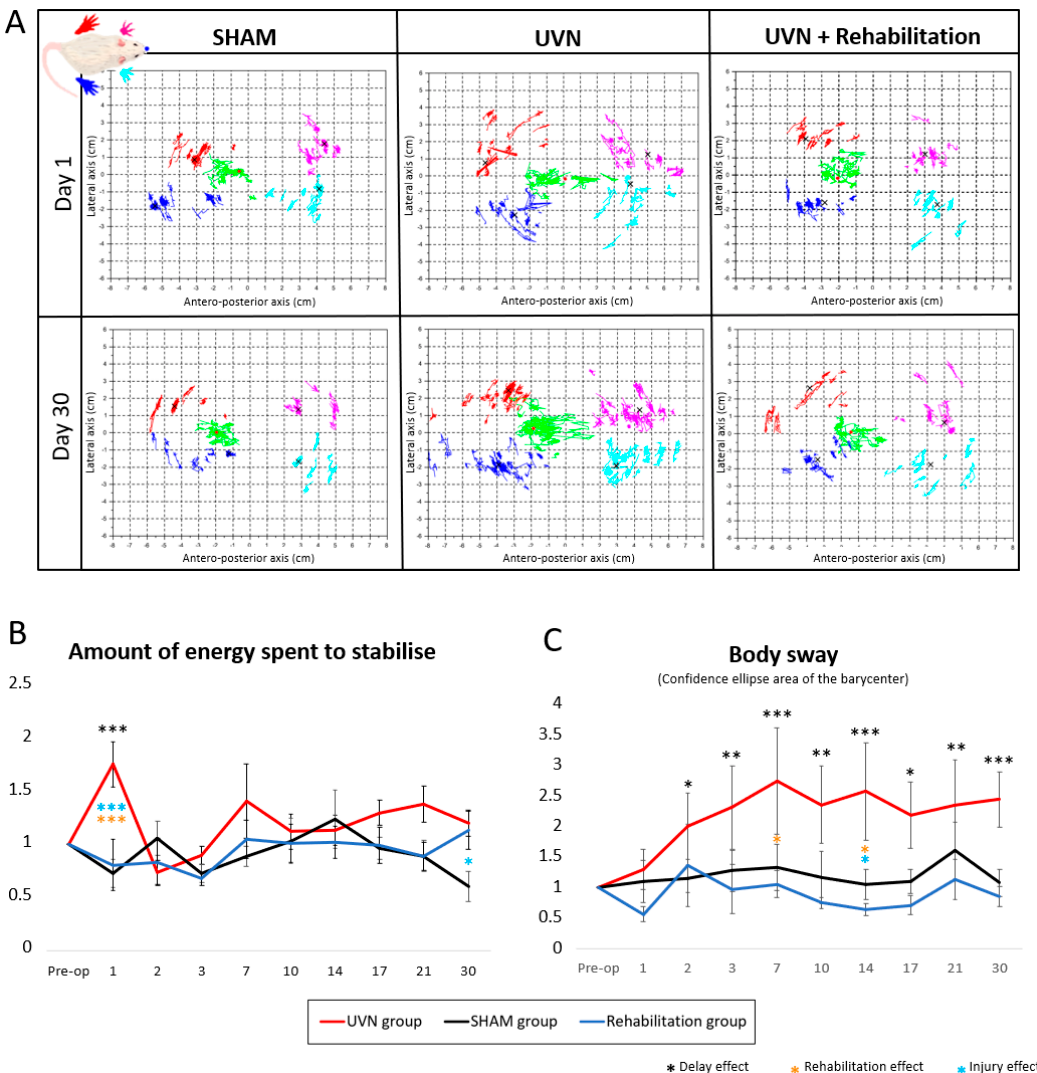
Figure 5. Posturographic parameters. ( A ) Rodent statokinesiograms: representation of the kinetics of the positions of the animals’ paws and the barycenter. The green clusters correspond to the positions of the barycentre during an acquisition, the red, blue, magenta and cyan dot clouds correspond to the left and right hind paws, and the left and right forepaws respectively. The different columns indicate the group of the animal from which the plot is extracted, and the lines indicate the acquisition time (day 1 and day 30 post-op). This figure is illustrative and allows the visualisation of the postural imbalance of the different groups in the study. These are examples of statokinesiograms obtained for one rat in each group. At day 1, the plot of the rehabilitation group showed less instability than the UVN group but more than the SHAM group. At D30, the statokinesiograms of the SHAM and rehabilitation groups seemed identical, whereas the instability seemed to persist in the UVN group. The following parameters quantify postural instability in the rodent. ( B ) Amount of energy spent to stabilize. From the preoperative session to post-injury day 21, the evolution of this parameter is similar for the rehabilitation group and the SHAM group. At D1, the UVN group spent significantly more energy than the other groups ( p < 0.001) and showed a delay effect ( p < 0.001). At D30, the SHAM group expended significantly less energy to stabilize than the UVN groups. ( C ) The body sway is a stability index frequently used in clinical posturology. This parameter highlights an instability that progressively sets in for the UVN group and that lasts (delay effect from D2 to D30: 0.05 < p < 0.001). The SHAM and rehabilitation groups managed to maintain their postural stability at all postoperative time